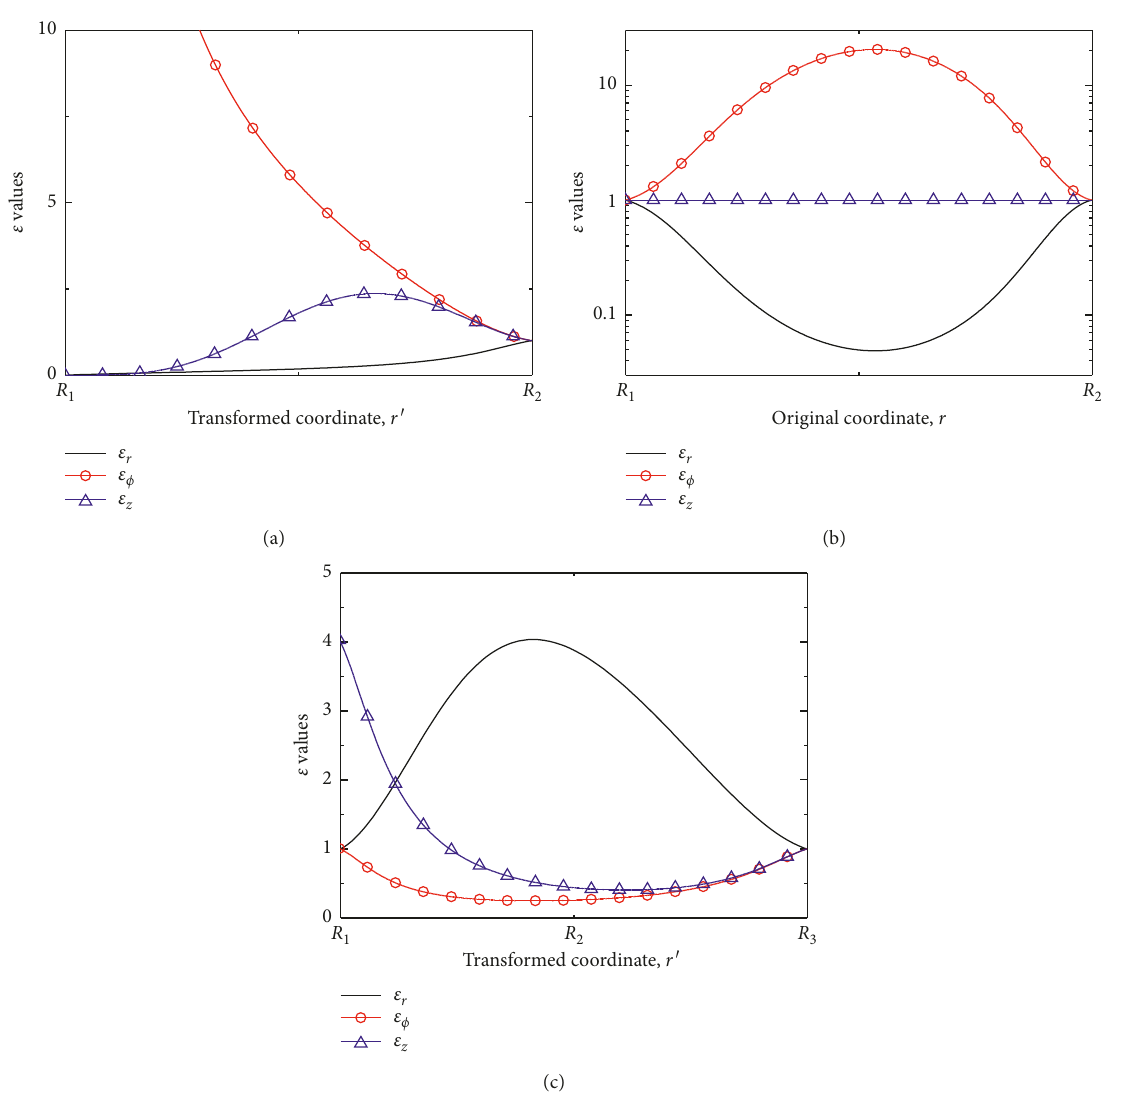
Figure 5: Material parameters of the fifth-order function: (a) the cloak, (b) the rotator, and (c) the concentrator. The parameters had smaller changes near boundaries and larger changes in the middle compared to those obtained with f 3 .